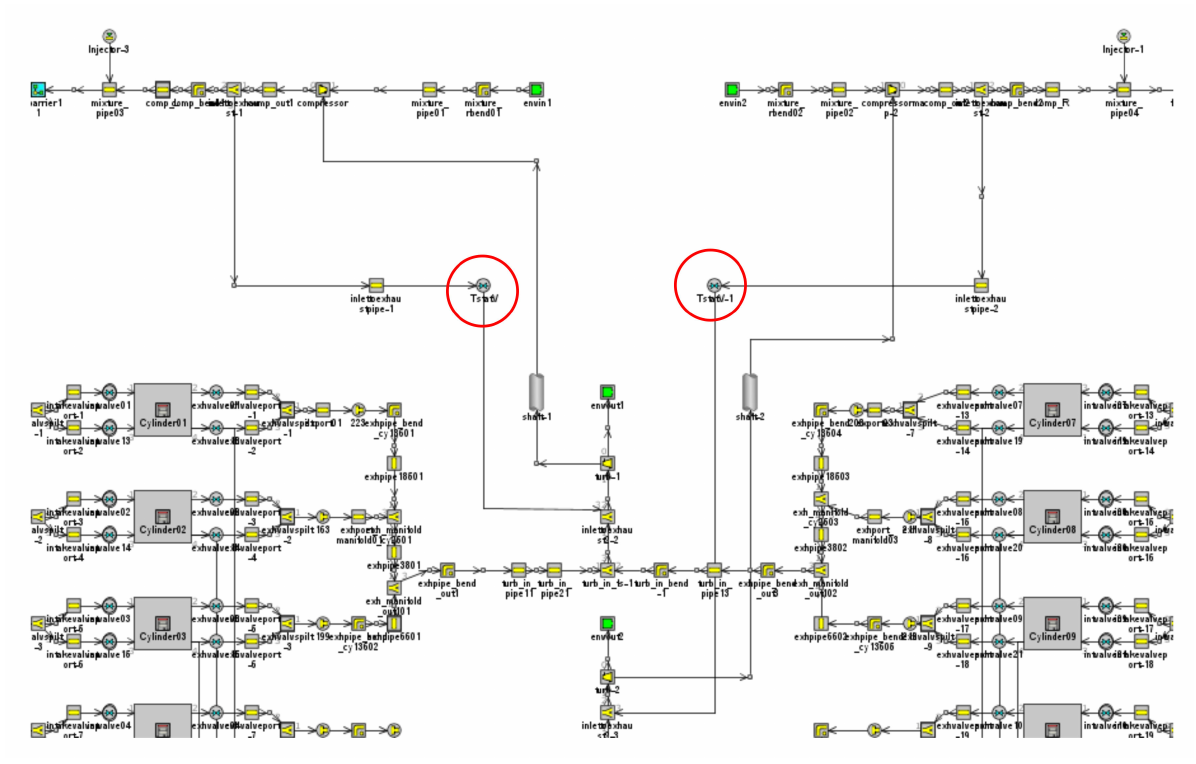
Figure 13. The improved intake system.